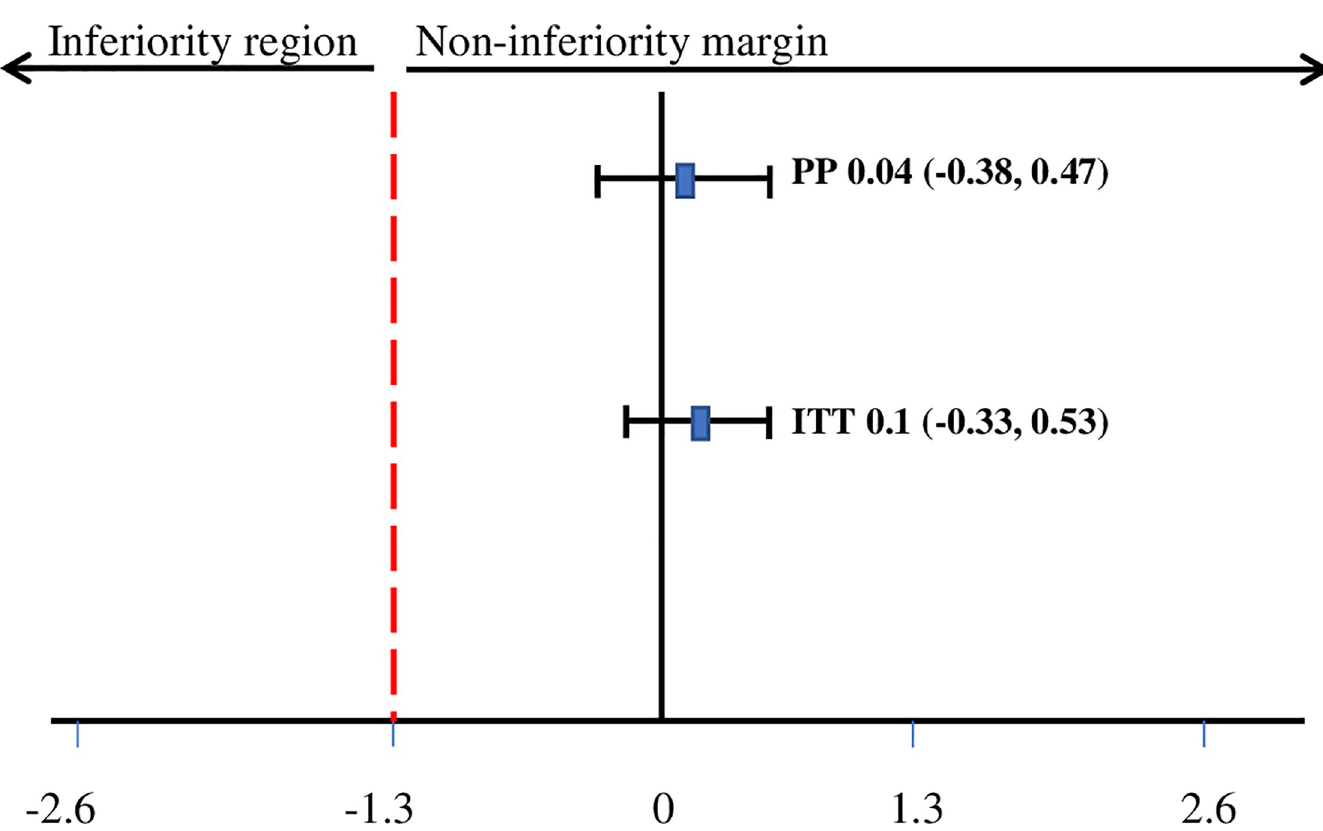
Fig 3. Difference in average weight gain (g/kg/day) between LIBS and CSB+ groups. The average daily weight gain in the LIBS group was non-inferior compared with the CSB+ group. Numbers are risk differences in average weight gains between groups (g/kg/day). The dotted line indicates the predefined non-inferiority margin. Abbreviations: LIBS: local-ingredients-based supplement; CSB+: corn-soy blend plus; PP: per-protocol; ITT: intention-to-treat. The generalized estimating equation was